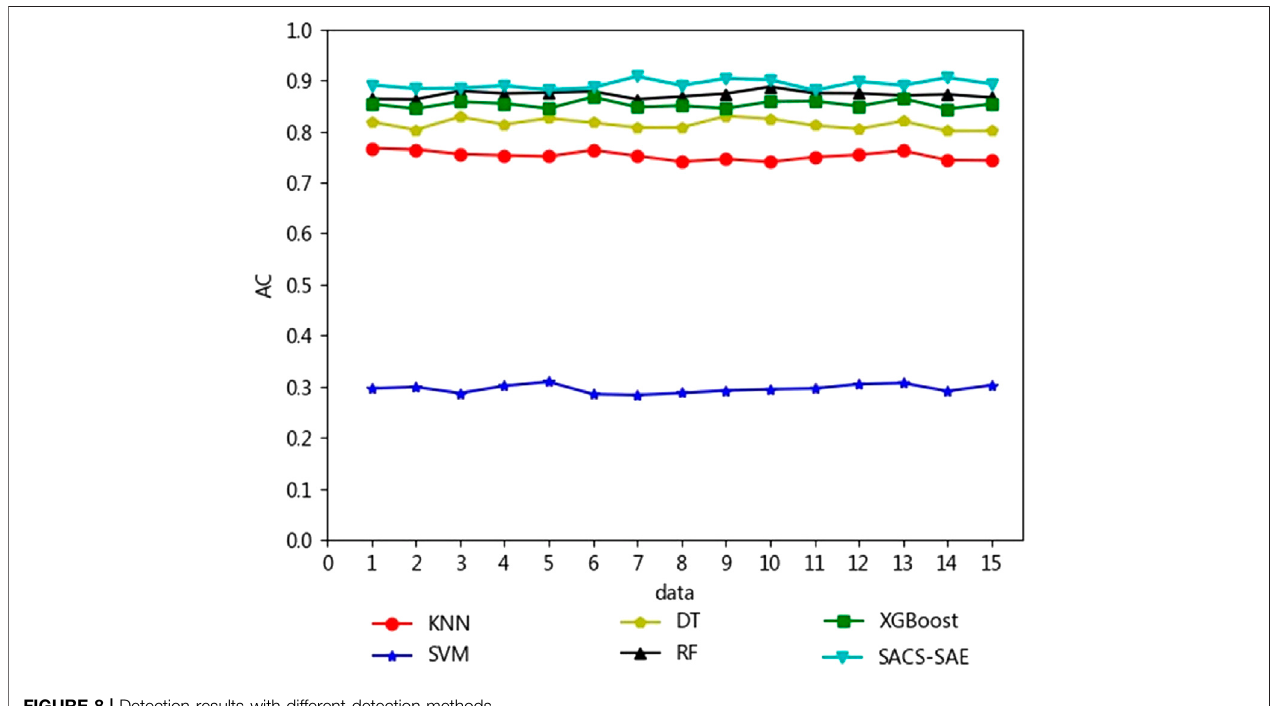
FIGURE 8 | Detection results with different detection methods.